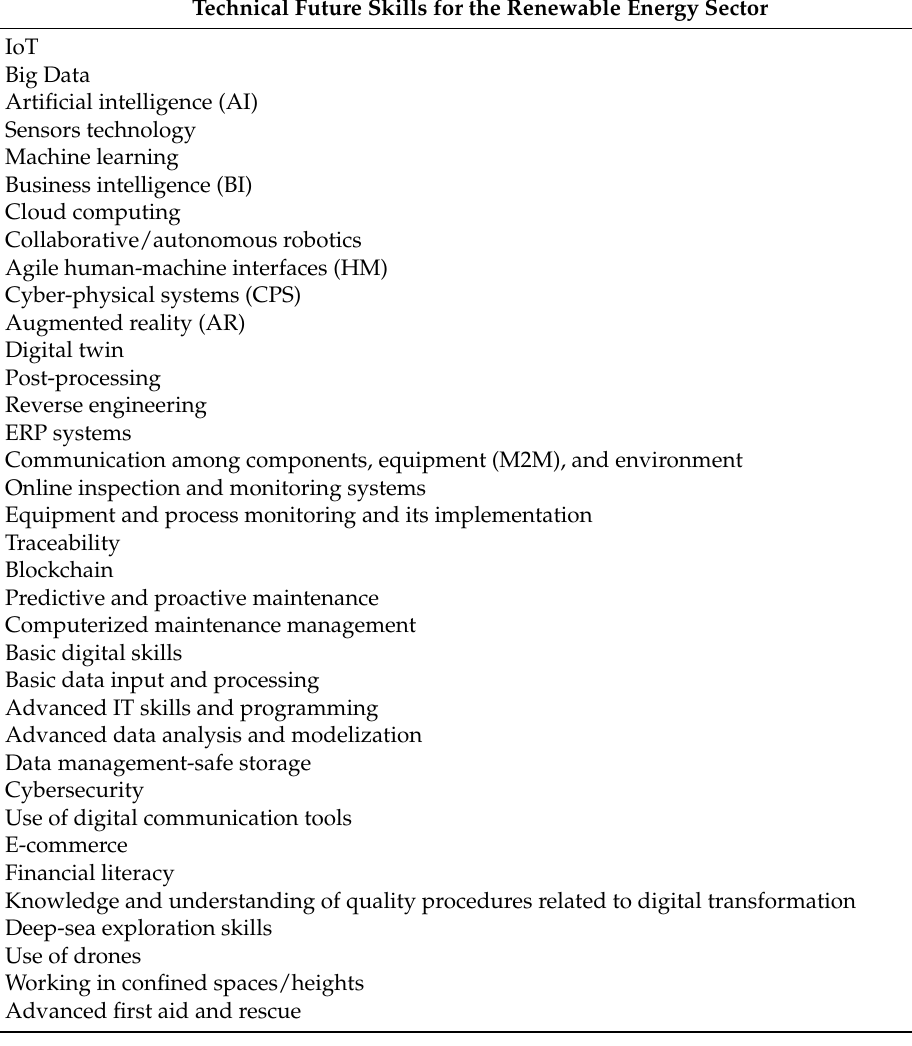
Table 2. List of selected future technical skills for the renewable energy sector workforce. Reprinted from Akyazi, T.; Goti, A.; Oyarbide-Zubillaga, A.; Alberdi, E.; Carballedo, R.; Ibeas, R.; and Garcia- Bringas, P.